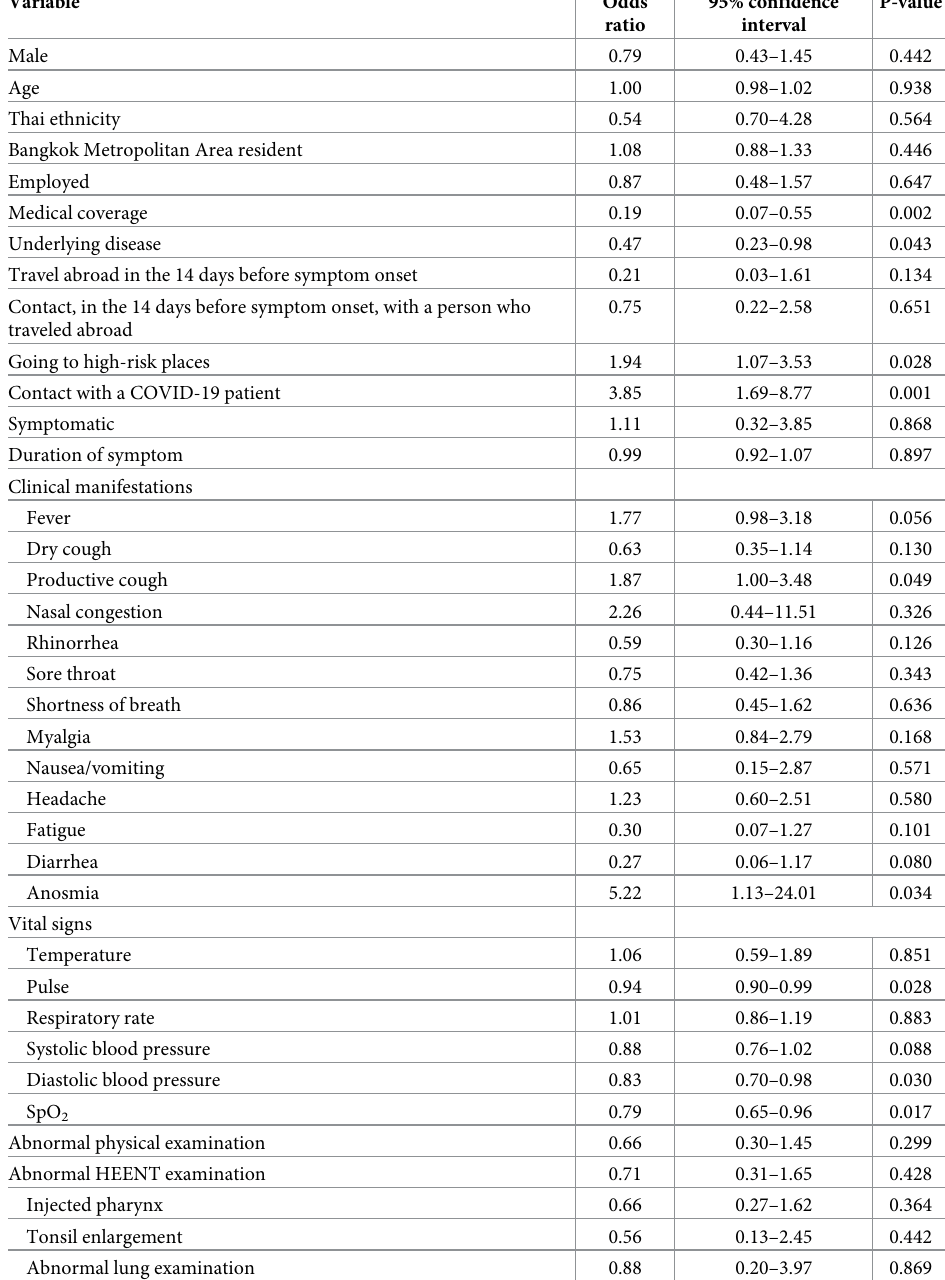
Table 4. Univariate logistic regression analysis of associated factors for COVID-19 (clinical characteristics and physical examinations).